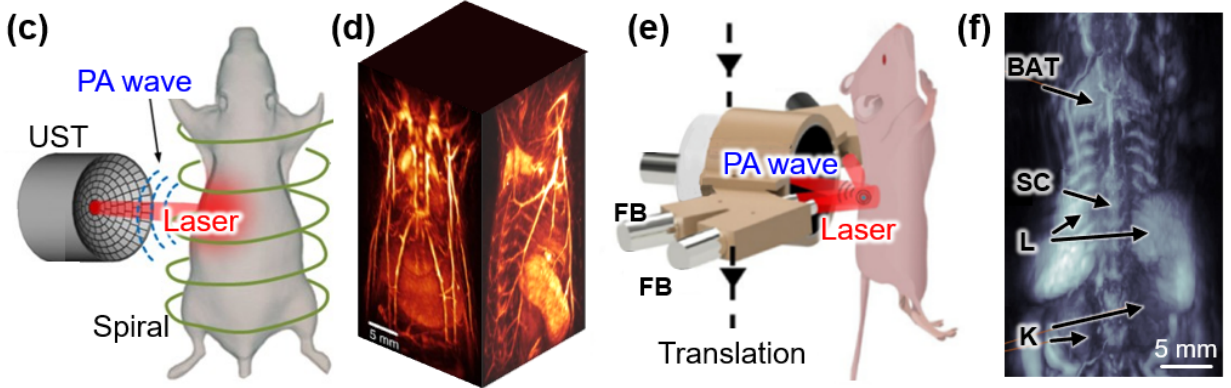
Figure 5. PAI systems with spherical array USTs. ( a ) Schematic of PAI system with a hemispherical array UST. ( b ) Volumetric PA image of the heat in a mouse. ( c ) Schematic of PAI system with a spiral scan using a spherical array UST. ( d ) Volumetric visualization of whole-body images of a mouse in vivo. ( e ) Schematic of PAI system with a translation scan using a spherical array UST. ( f ) Volumetric PA whole-body image of a mouse in vivo. PA, photoacoustic; PAI, photoacoustic imaging; UST, ultrasound transducer; DAQ, data acquisition module; FB, fiber bundle; IJV, internal jugular vein; RSV, right subclavian vein; LSV, left subclavian vein; SVC, superior vena cava; AA, aortic arch; RA, right atrium; LA, left atrium; RTA, right thoracic artery; LTA, left thoracic artery; RV, right ventricle; LV, left ventricle; IA, intercostal artery; REV, right epigastric vein; LEV; left epigastric vein; BAT, brown adipose tissue; SC, spinal cord; L, liver; K, kidney. The images are reproduced with permission from Refs.